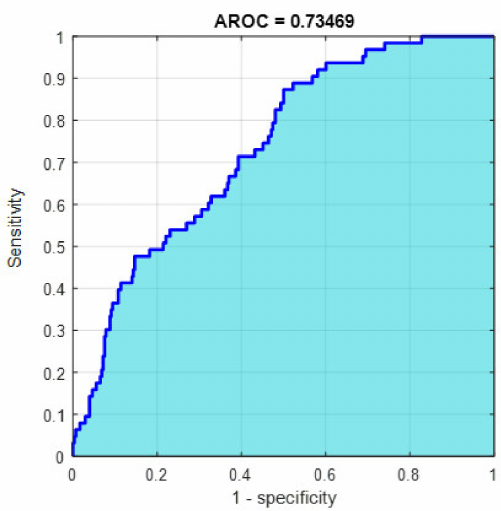
Figure 16. The AROC with ECFS-reduced features for type grading.